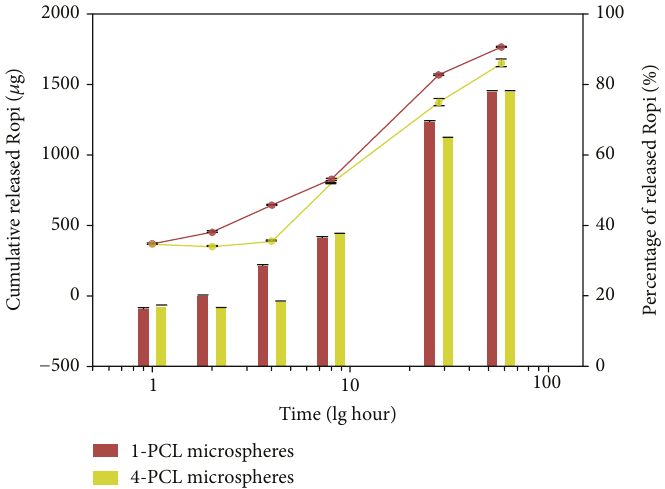
Figure 6: Accumulated Ropi released from 1-PCL spheres (red) and 4-PCL spheres (green). Ratio of released Ropi is displayed as the bar